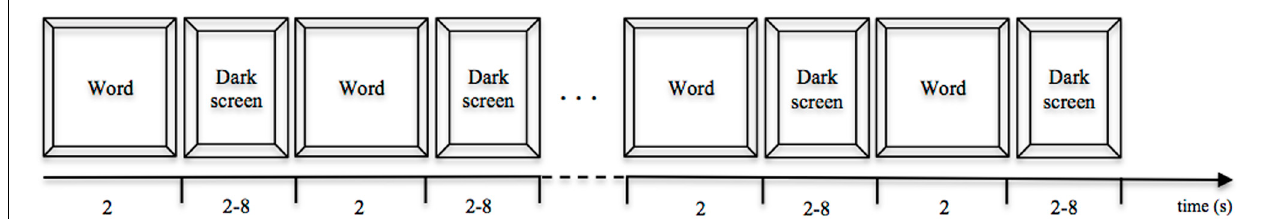
FIGURE 4 | Event-related design for Dream stimulus presentation. Word series of 120 words comprising 30 Dream-Words and 30 Neutral-Words previously learned + 60 Distractor-Words (not learned); presented in random order with variable Inter-Stimulus-Interval (ISI) of 2–8s (mean 6.2s).